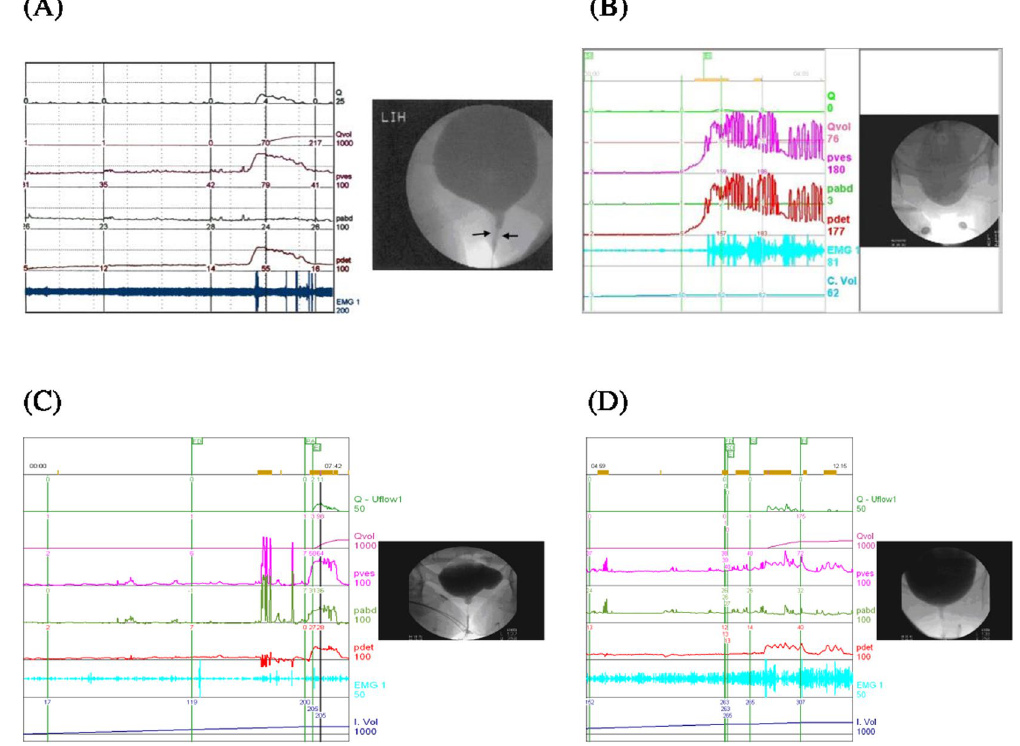
Figure 1. Videourodynamic findings of the subtypes of bladder outlet obstruction: ( A ) urethral stricture, ( B ) bladder neck dysfunction, ( C ) dysfunctional voiding and ( D ) poor relaxation of the external sphincter.